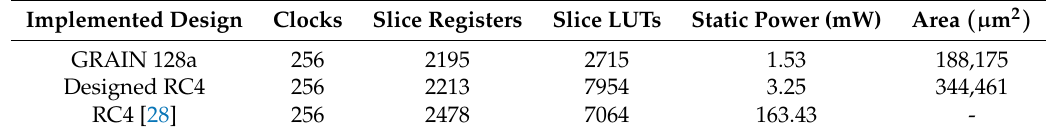
Table 2. Hardware area and power consumption of RC4 and Grain 128a stream ciphers